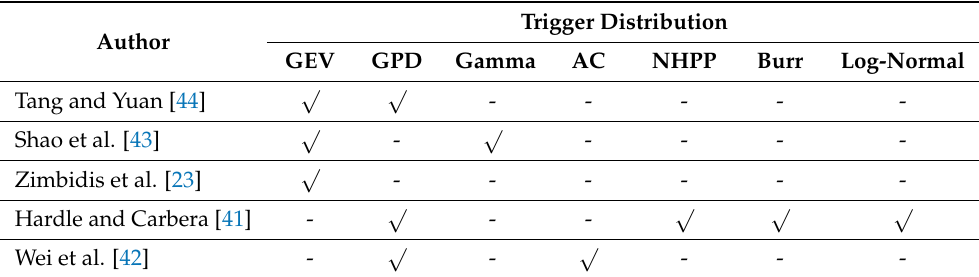
Table 7. Summary of the trigger distribution models used in primary studies.